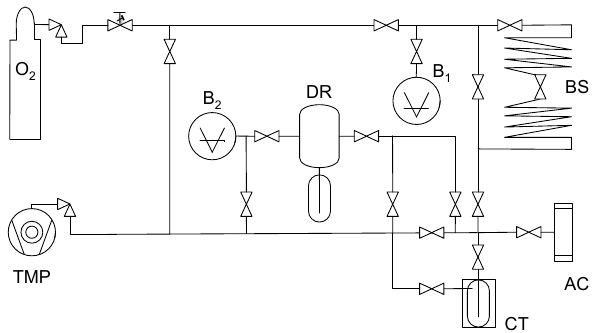
Figure 1. Vacuum system for ozone sample preparation. AC: UV absorption cell; B 1 : Baratron 690 (10Torr); B 2 : capacitive pres- sure gauge (1000hPa); BS: gas buffer spiral; CT: cold trap operable at 65K; DR: electric discharge reactor chamber (3L); and TMP: turbo-molecular